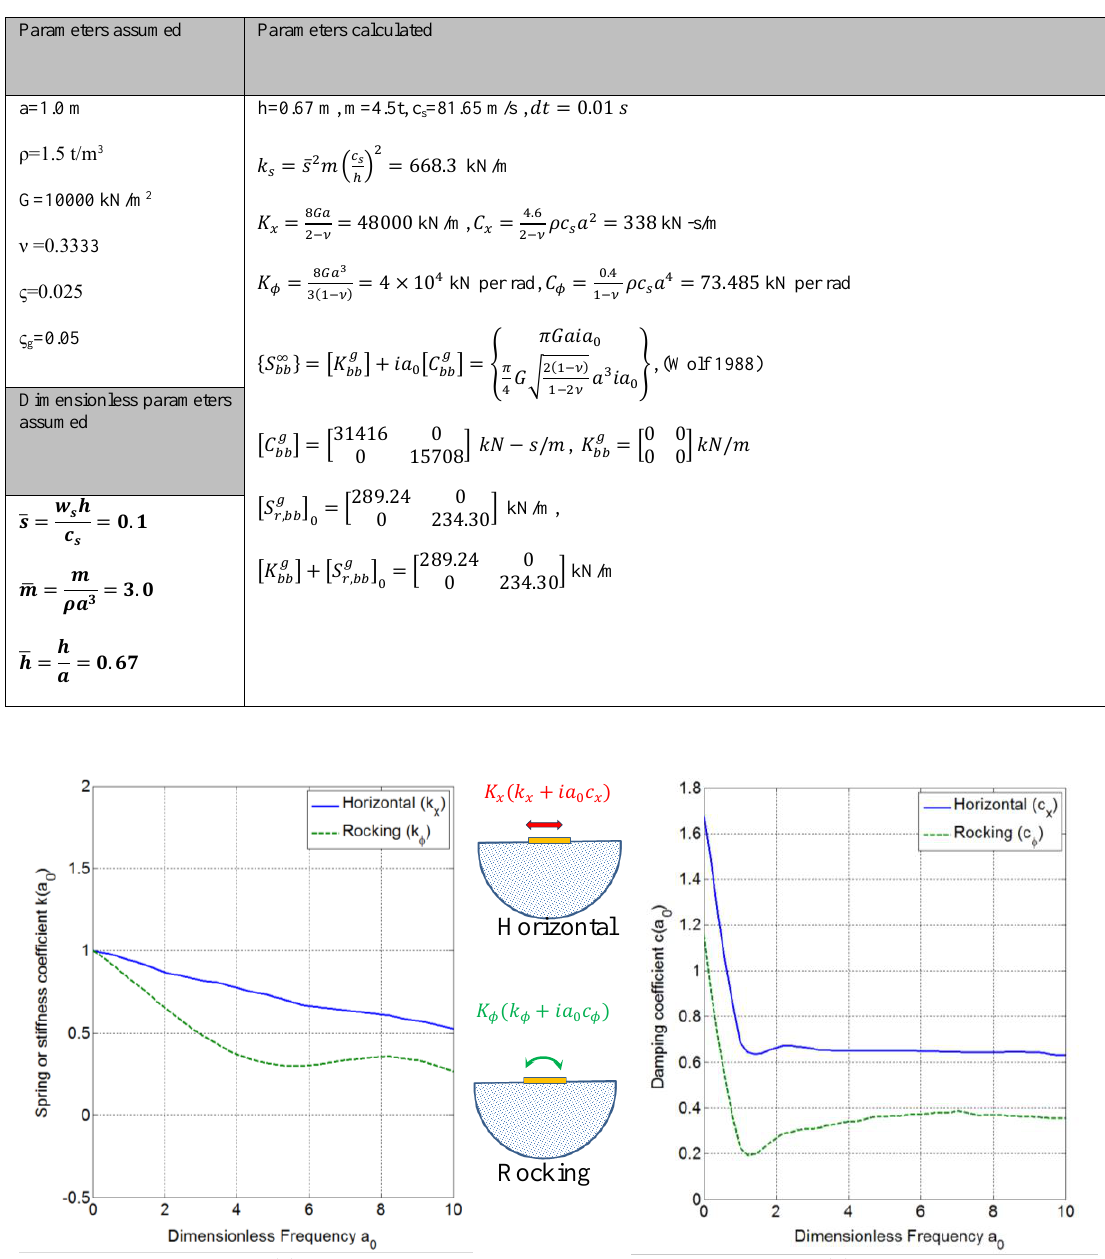
Table 3. Parameters defining the 3DOF dynamic system